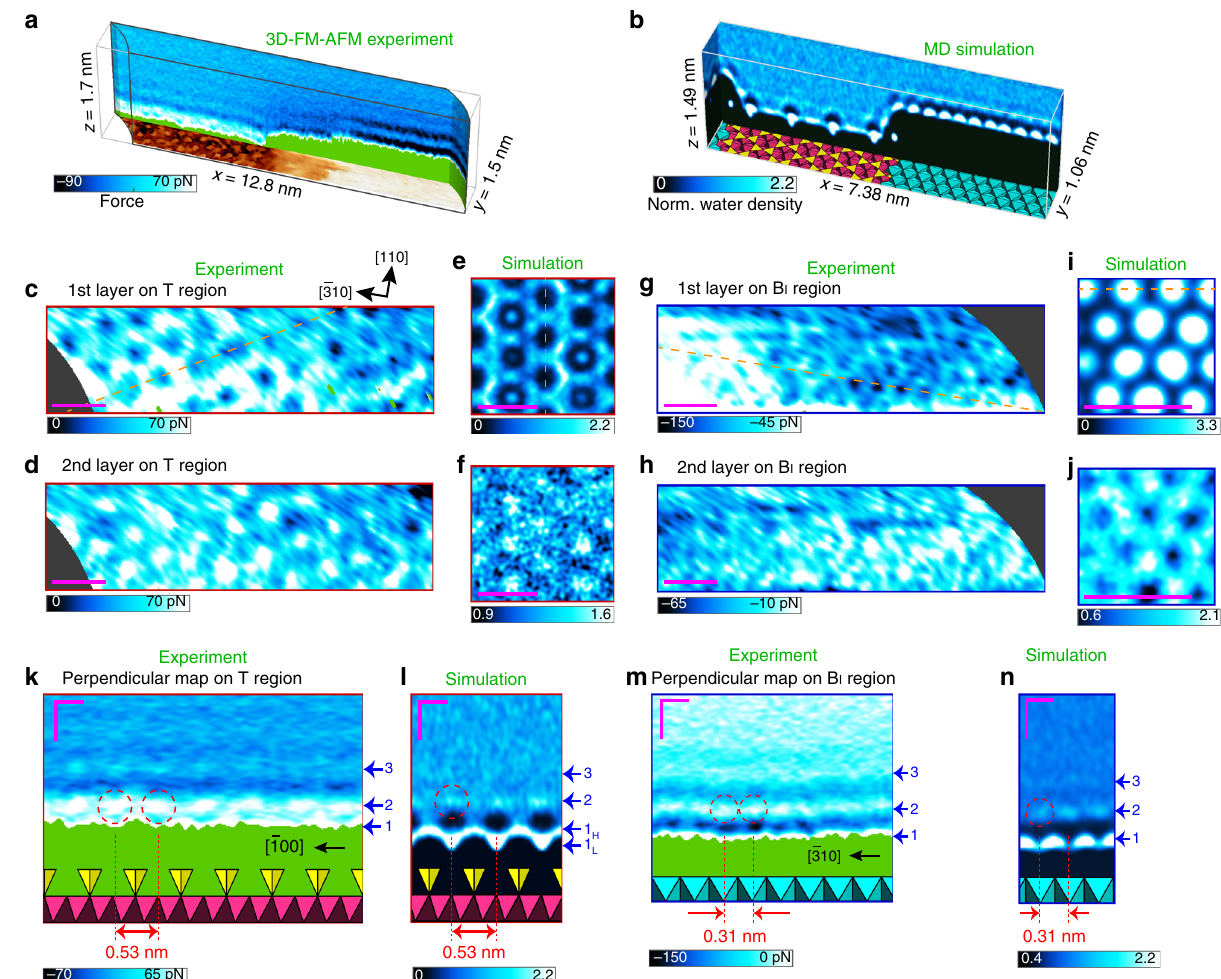
Fig. 2 Comparison of 3D FM-AFM and MD results on each terrace region. a , b Representations of 3D force map ( a ) and MD simulation ( b ) on the clinochlore (001) surface. c , d , g , h Lateral 2D force maps measured at the tip heights presumably corresponding to the fi rst ( c ) and second ( d ) layers on the T region, and the fi rst ( g ) and second ( h ) layers on the B region. e , f , i , j Theoretical lateral 2D-normalised water (oxygen) density maps of the fi rst higher ( e ) and second layers ( f ) on the T region, and the fi rst ( i ) and second layers ( j ) on the B region. k , m Perpendicular 2D force maps along the broken lines in c on the T region ( k ), and g on the B I region ( m ). l , n Theoretical perpendicular 2D-normalised water (oxygen) density maps along the broken lines in e on the T region ( l ), and i on the B region ( n ). The adsorbed fi rst lower layer in the centre of the honeycomb and the fi rst higher layer forming the honeycomb-like pattern are shown as 1 L and 1 H , respectively. The red broken circles indicate the periodic hydration structures. Zero-distances in the simulations are de fi ned as the centres of the oxygen atoms of each surface. Scale bars: 0.8 nm ( c – j ) and 0.3 nm ( k – n